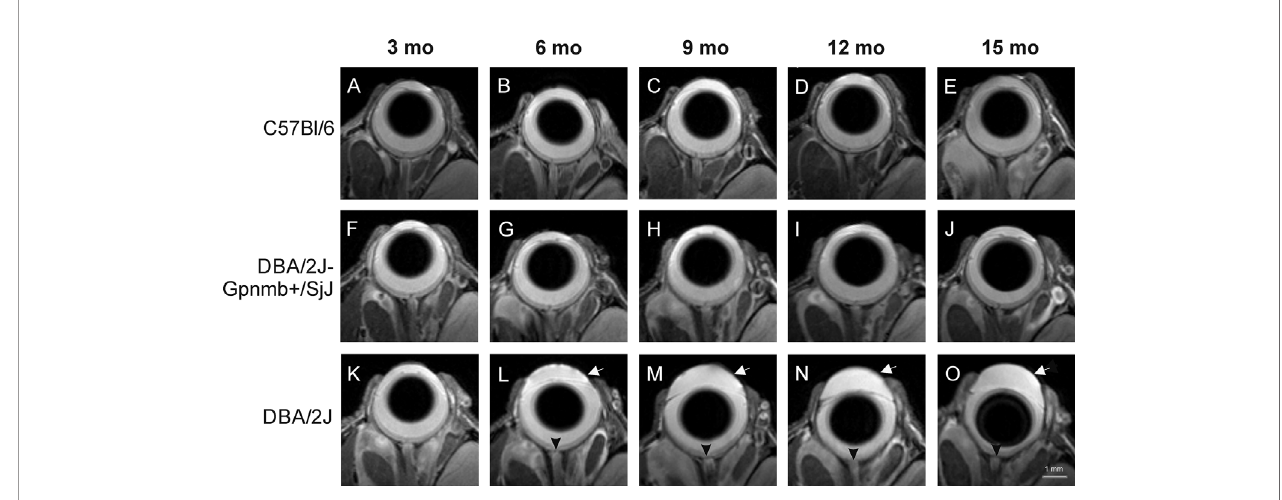
FIGURE 2 | Age-dependent changes in eye morphology in C57BL/6J ( fi rst row, A – E ), DBA/2J-Gpnmb + /SjJ (second row, F – J ), and DBA/2J (third row, K – O ) mice. DBA/2J mice display anterior chamber deepening (arrow) and optic disc cupping